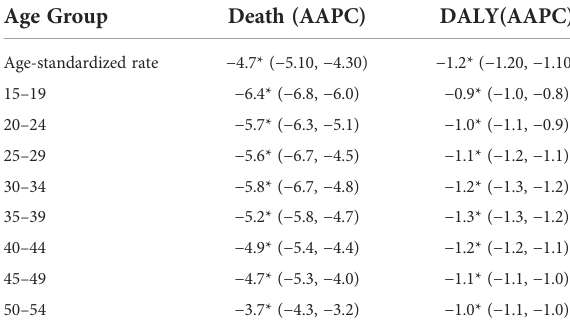
TABLE 2 The average annual percent changes (AAPCs) in death and DALY of endometriosis in China, 1990 –